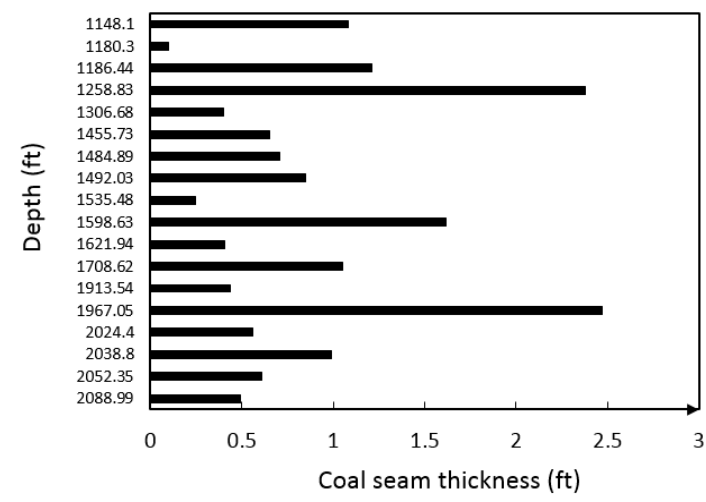
Figure 2. Coal seam thickness in the test well.